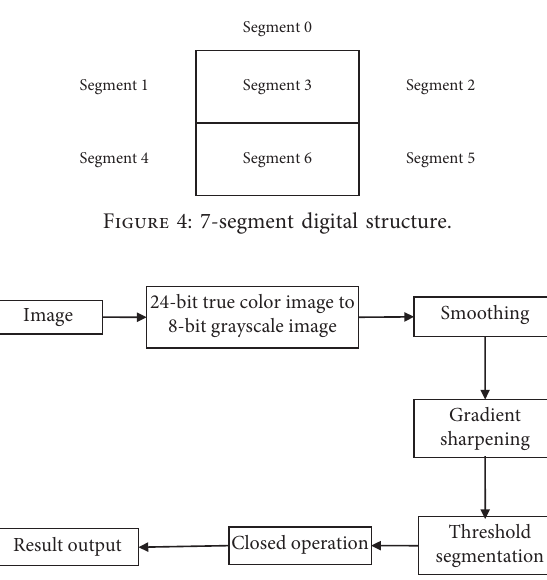
Figure 5: The processing process of the pointer image.